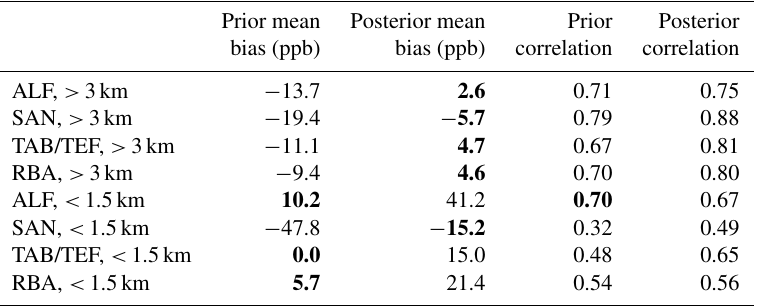
Table 2. Prior and posterior bias (ppb) and correlation between TOMCAT and Amazon flight observations (2010–2018). The better value for bias and correlation for each site and altitude is highlighted in bold. Prior mean Posterior mean